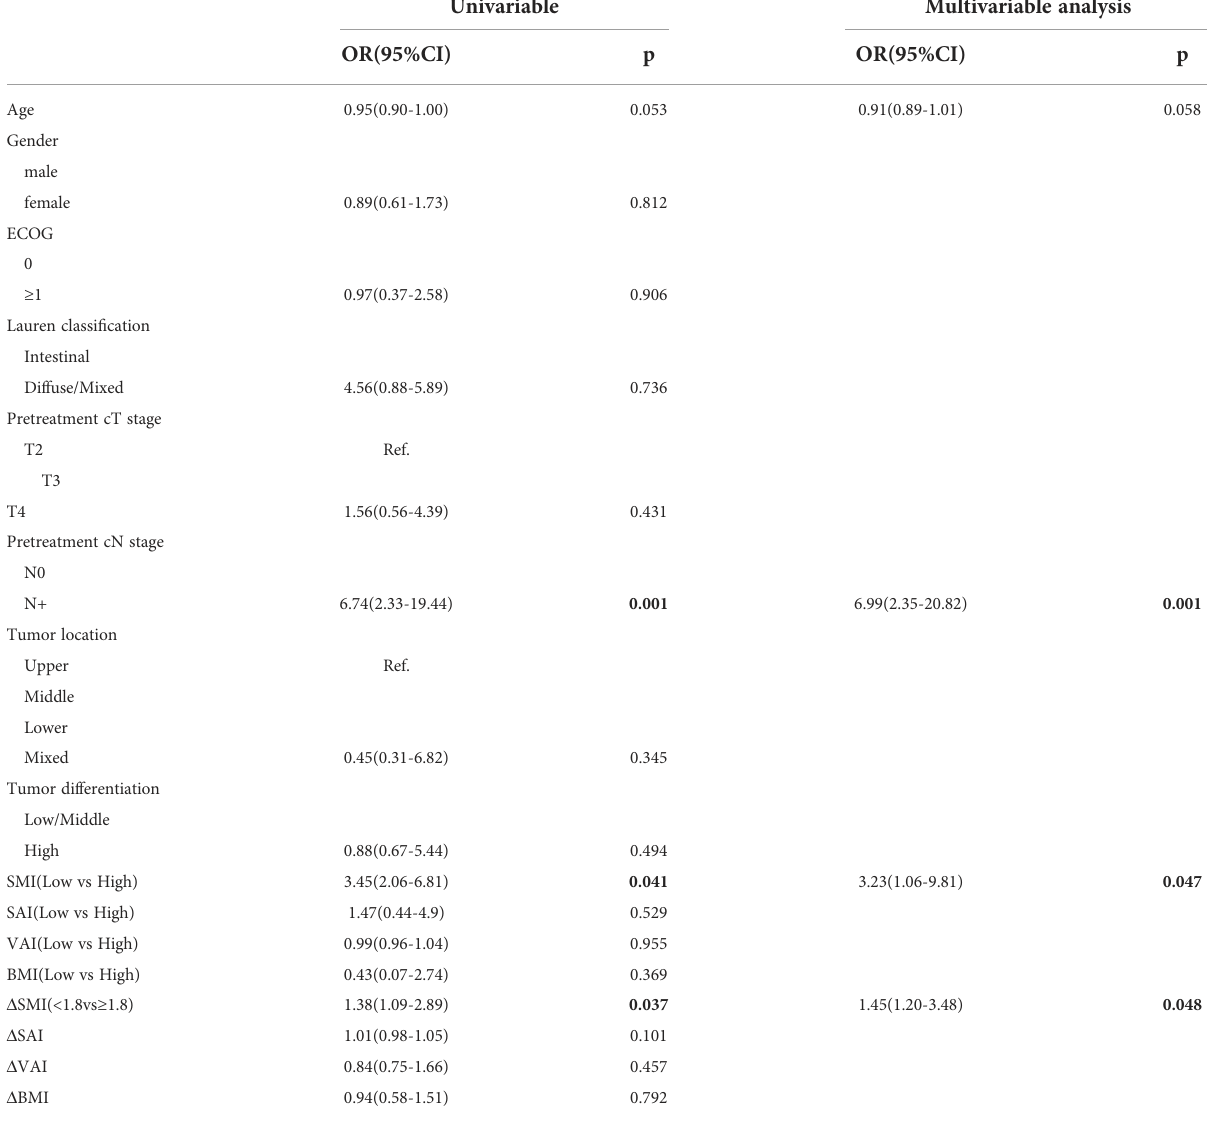
TABLE 4 Univariate and multivariable analysis of the relationship between body composition with